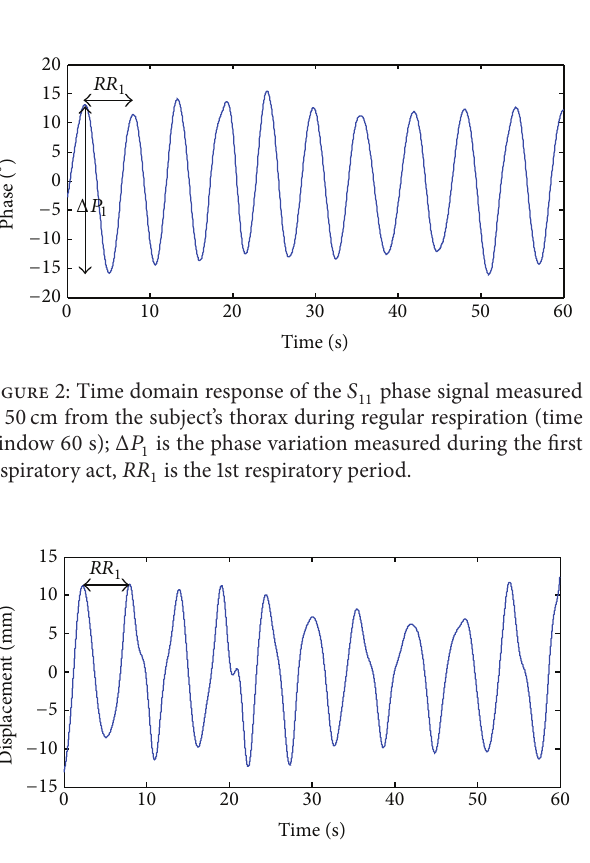
Figure 3: Distance variation Δ𝐷 of the subject’s thorax (sternum) measuredbyLDViat50 cmduringregularrespiration(timewindow 60 s); 𝑅𝑅 1 is the 1st respiratory